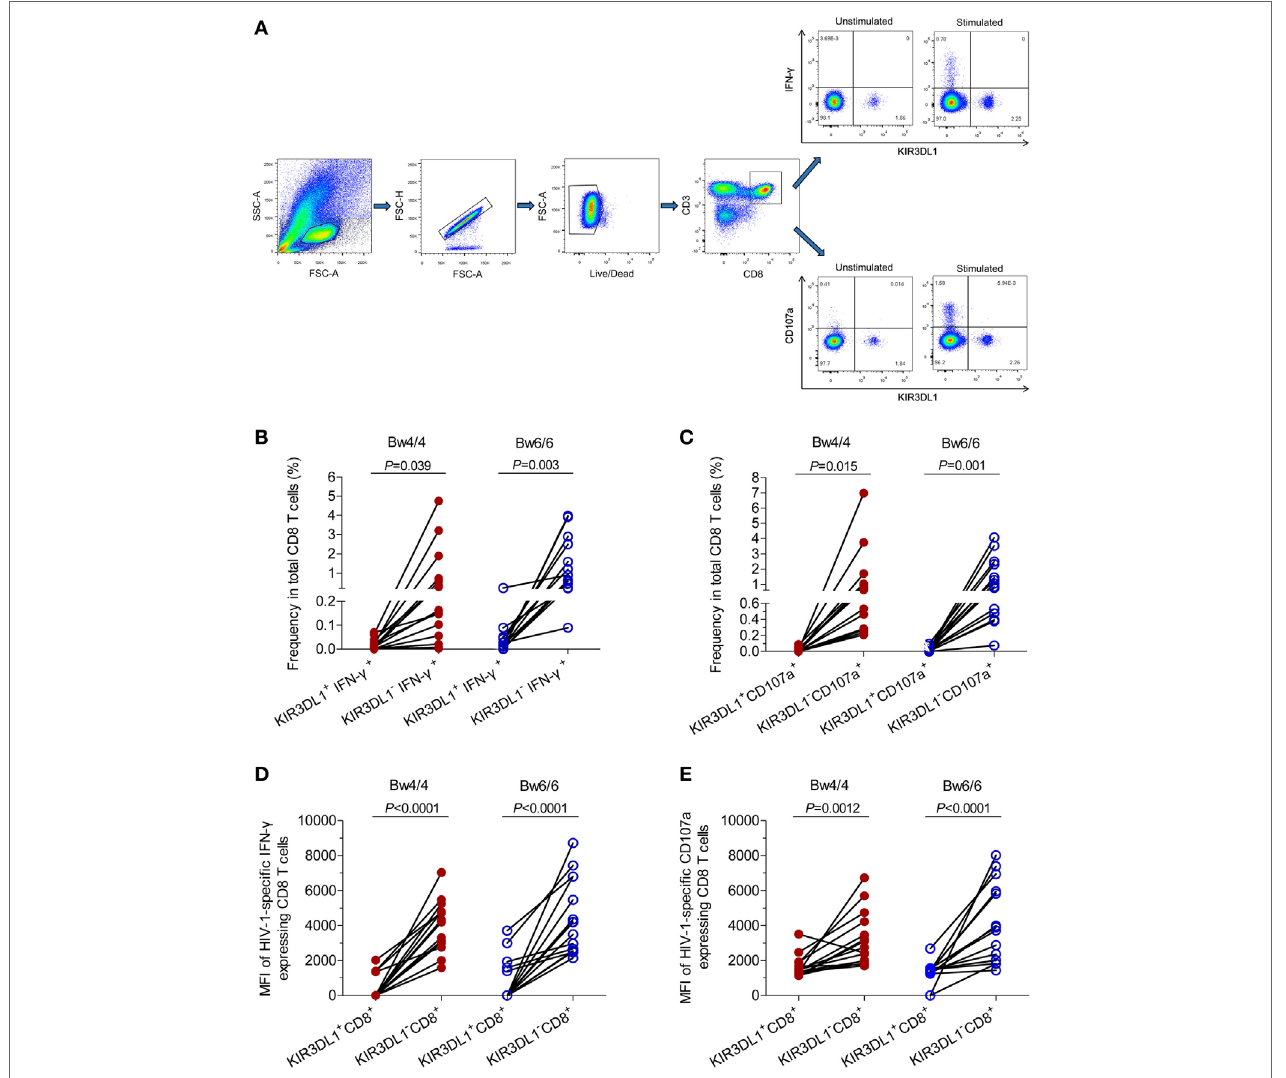
FigUre 5 | Median fluorescence intensity and levels of human immunodeficiency virus type 1 (HIV-1)-specific IFN- γ and CD107a produced by CD8 T cells, in Bw4 and Bw6 homozygotes. (a) Gating strategy for flow cytometric analysis of IFN- γ and CD107a expressing in CD8 T cells; (B) frequency of KIR3DL1 + IFN- γ + cells and KIR3DL1 − IFN- γ + cells among total CD8 T cells stimulated with HIV-1 p24 peptides; (c) frequency of KIR3DL1 + CD107a + and KIR3DL1 − CD107a + cells among total CD8 T cells stimulated with HIV-1 p24 peptides. The difference in median fluorescence intensity for the HIV-1-specific IFN- γ (D) and CD107a (e) released by KIR3DL1 + CD8 + and KIR3DL1 − CD8 + T cells. The Bw4/4 and Bw6/6 motifs are shown in red and blue, respectively. Paired Student’s t -tests were used to compare groups, with P < 0.05 considered